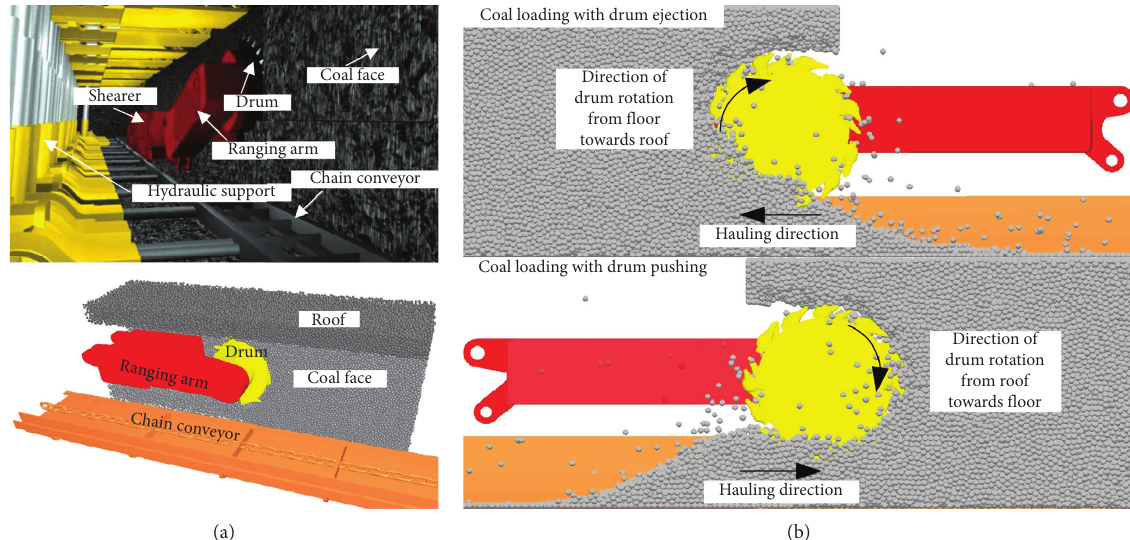
Figure 3: (a) Shearer in operation; (b) the coal loading process of the drum in simulation.